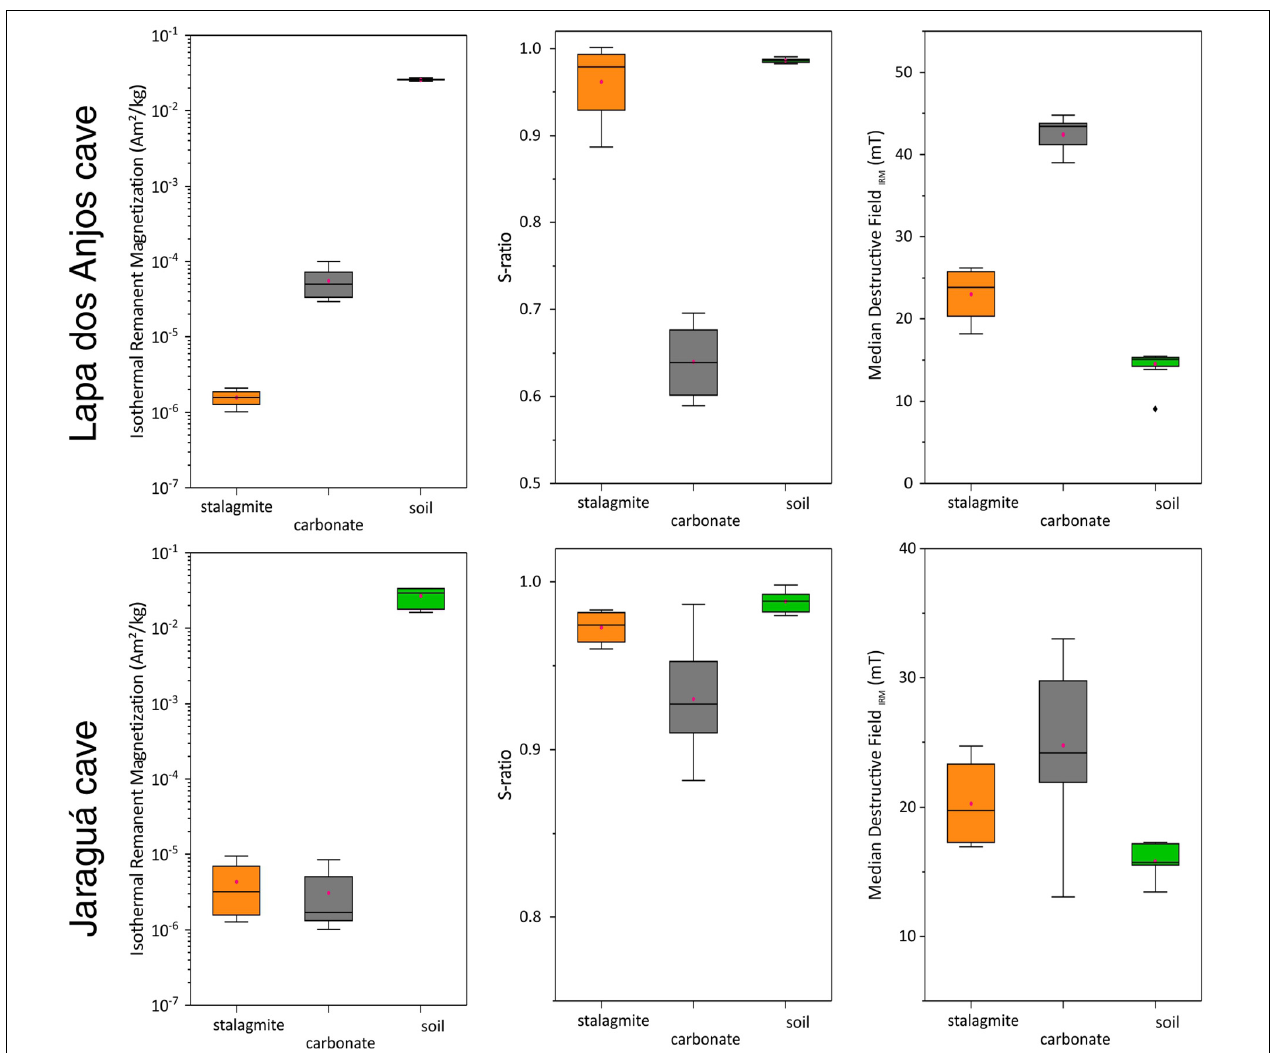
FIGURE 8 | Magnetic properties of the caves: Lapa dos Anjos (upper) and Jaraguá (bottom). ( First column ) Isothermal remanence magnetization (IRM) after a pulse-field of 1T. ( Second column ) S-ratio shows the presence of the low-coercivity phase. ( Third column ) Median destructive field from IRM demagnetization. The box-plot are referred to stalagmites (orange), soil (green), and carbonates